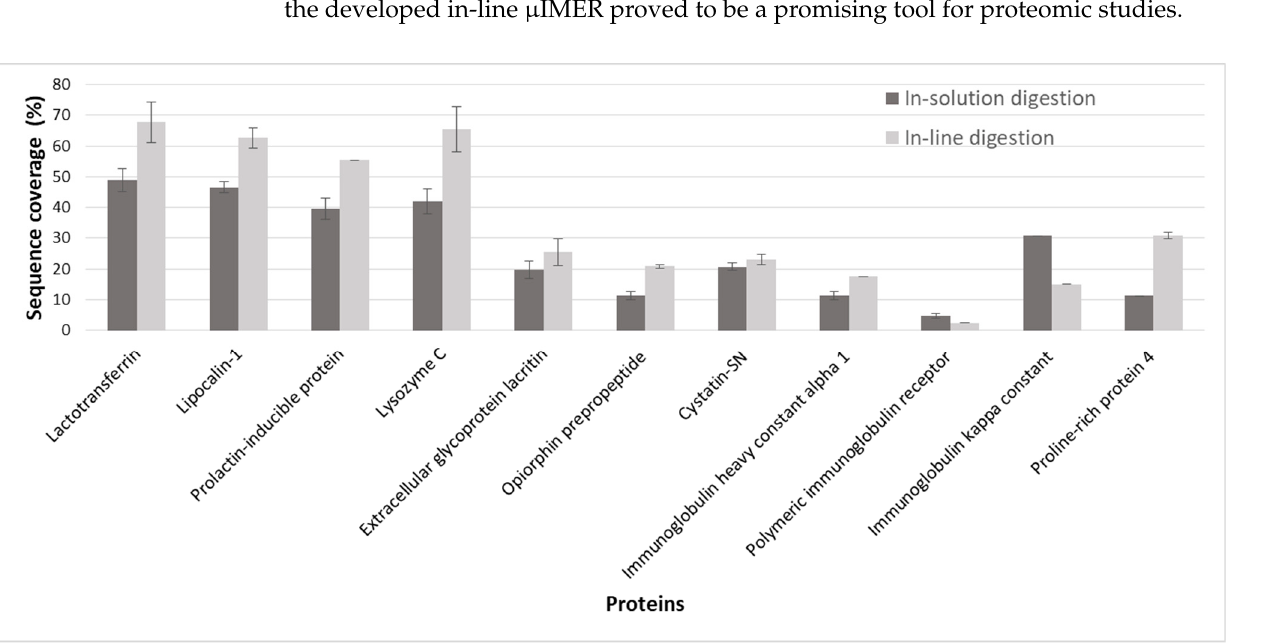
Figure 7. Identified proteins and their sequence coverage values in human tear sample with in-solution and in-line digestion using CZE-MS/MS. A total of 11 proteins identified with at least two unique peptides are shown. Preconditioning: BGE (1 bar · 180 s), trypsin solution ((50 mbar · 100 s, 60 s wait time, − 50 mbar · 120 s) × 3), water ( − 50 mbar · 120 s), and BGE (1 bar · 60 s). Injection: sample (50 mbar · 60 s), BGE (15 mbar · 70 s), 300 s wait time, and BGE (15 mbar · 70 s). Other parameters were the same as in Figure 4.